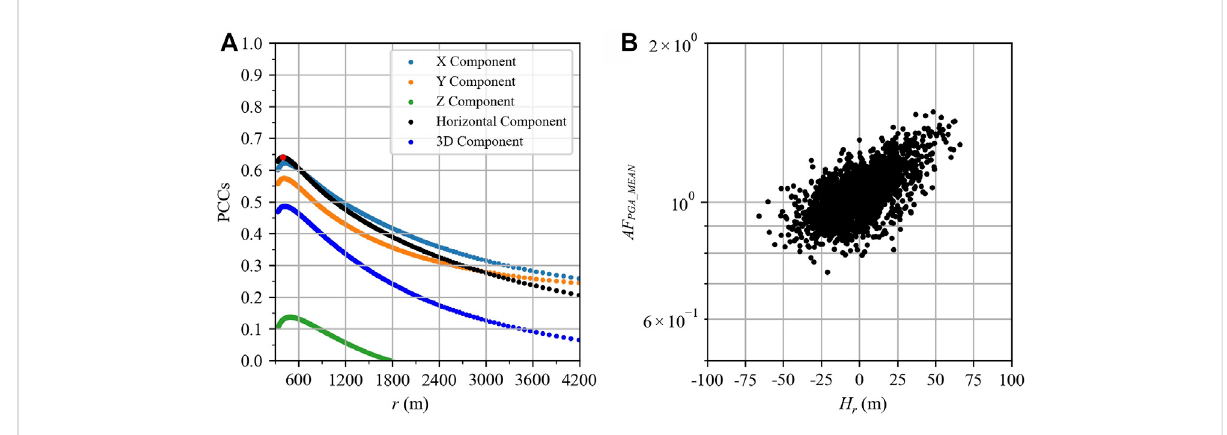
FIGURE 7 Correlationbetween AF PGA mean and H r . (A) PCCsofservalcomponentsobtainedbetween H r and AF PGA MEAN ; (B) Thehorizontal AF PGA MEAN and H r of the 3,721 receivers indicated by the red dot in (A) .